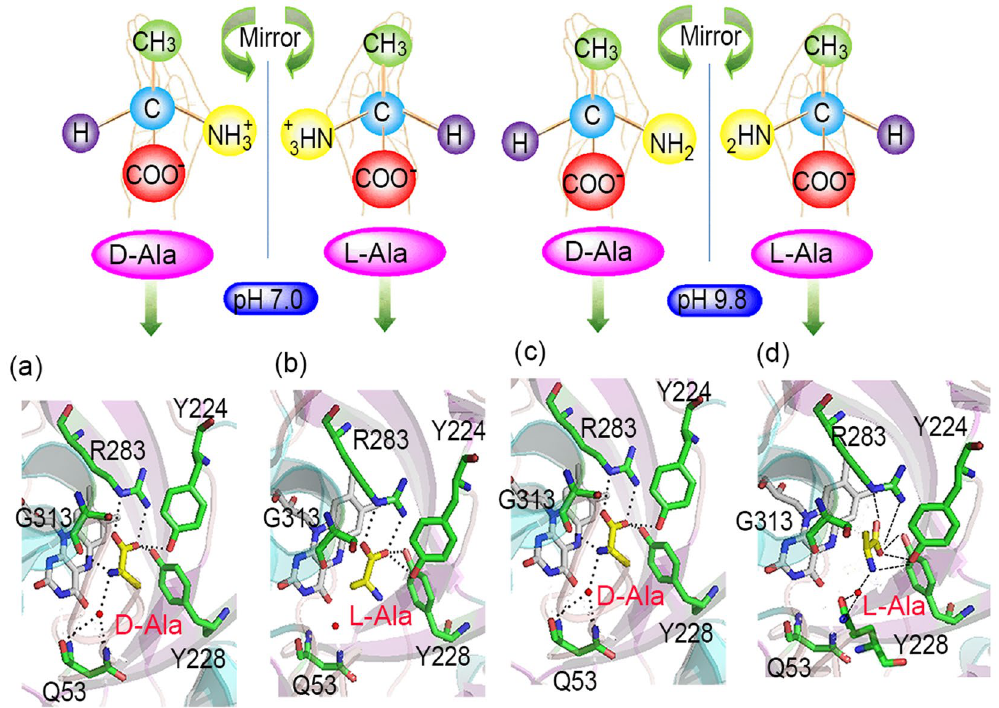
Figure 2. Graphical presentation of the active site cavity of DAAO in complex with both enantiomers of Ala at different pH. The active site residues, the L-Ala and D-Ala molecule were shown in stick representation colored in green (carbon atoms), blue (nitrogen atoms) and red (oxygen atoms). The molecular modeling displayed DAAO in complex with D-Ala at pH 7.0 ( a ), DAAO in complex with L-Ala at pH 7.0 ( b ), DAAO in complex with D-Ala at pH 9.8 ( c ), DAAO in complex with L-Ala at pH 9.8 ( d ),